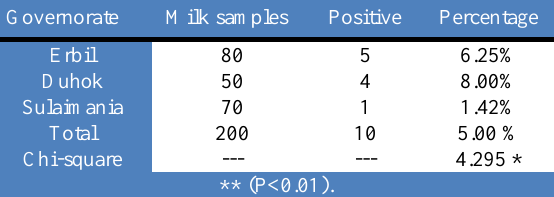
Figure, (1-A and B): Shows positive Real time PCR amplification for M. agalactiae for 200 DNA extract from 200 milk samples.